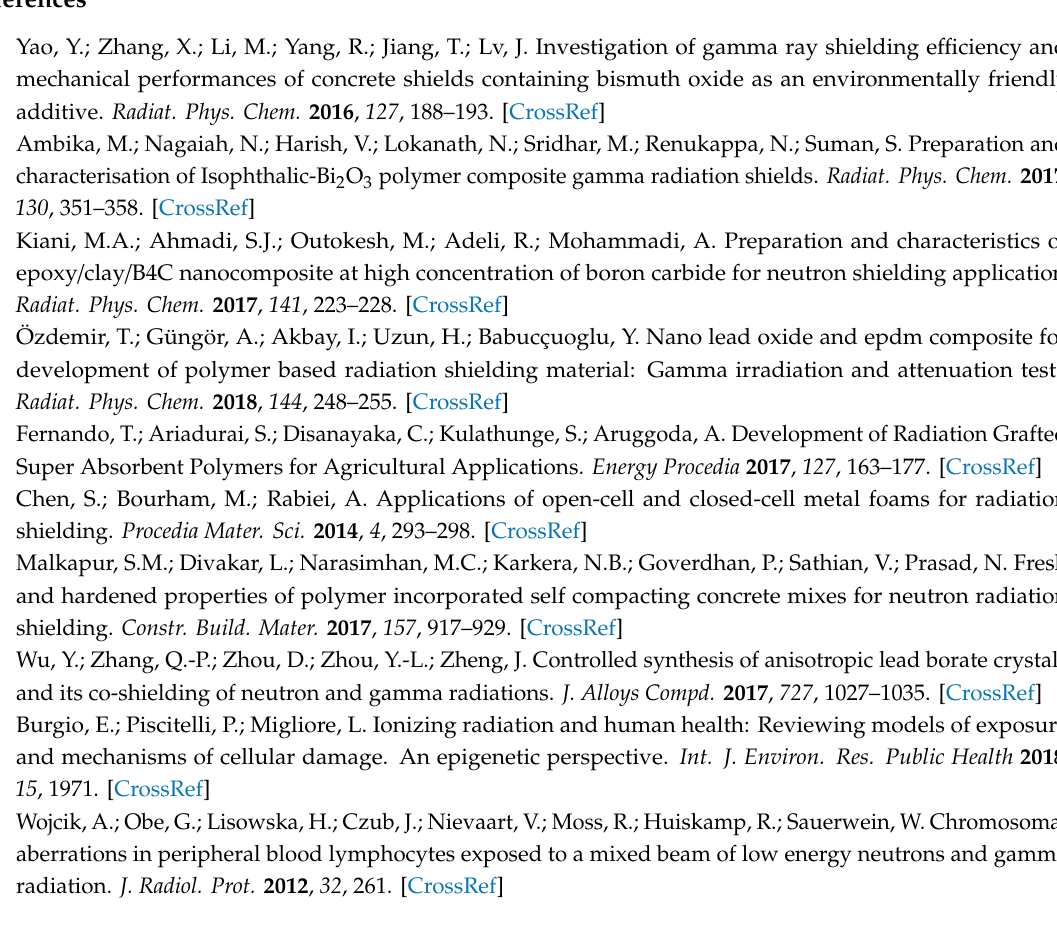
Figure S1. Formation of GO out of pure graphite flakes, Table S1. Specification of developed samples, Table S2. I D / I G ratio obtained by current method compared with literature, Table S3. Element analysis of fabricated GO via XPS, Table S4. De-convolution of peak C1s into five diverse segments, Table S5. De-convolution of peak N1s into three diverse segments, Table S6. De-convolution of peak O1s into four diverse segments, Table S7. XPS and XRD results comparison between previous methods and current study, Table S8. EDAX analysis of hybrid GO-ITN flakes, Table S9. Specification of appeared peaks of iron tungsten nitride’s structure, Table S10. Performance of the developed shields against incident X-ray